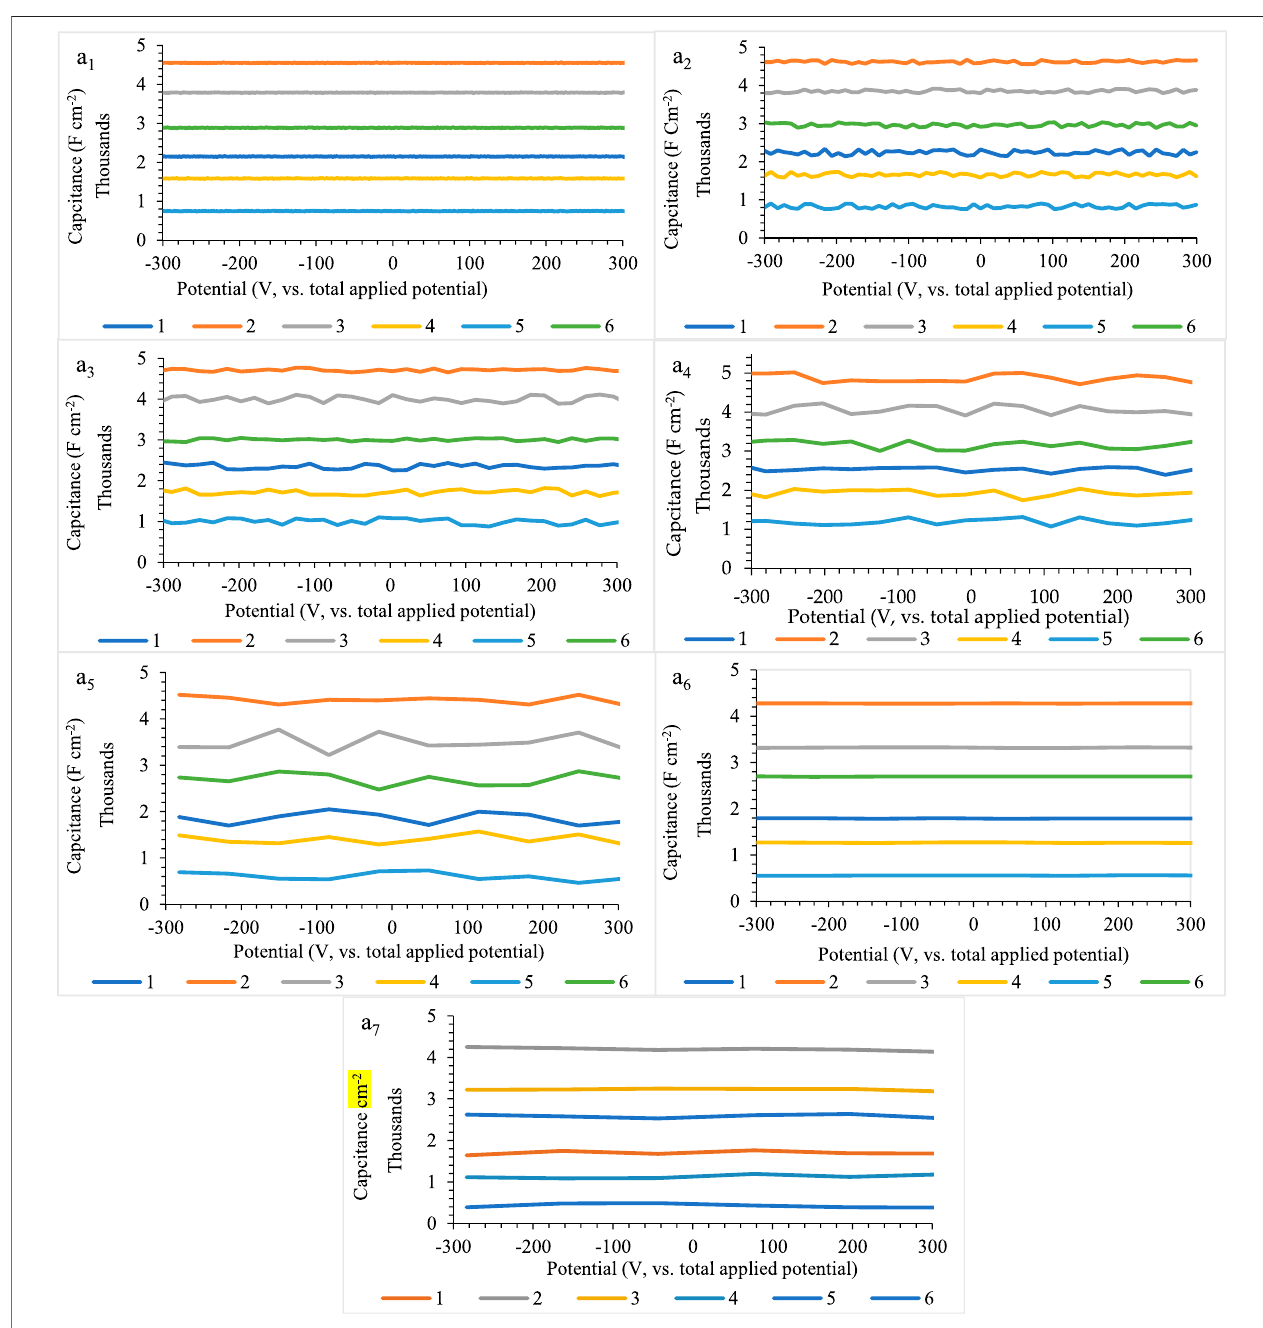
FIGURE 3 | (A) Effect of scan rate on the capacitance stability (a 1 – a 7 ) for fi ve independent repeats during implanting of three microelectrodes with 0.0124 ± 0.0008 mm inter-electrode distance, error bar: ± standard deviation ( n (cid:2) 5). Note that to prevent clutter, error bars eliminated are from different parts of the fi